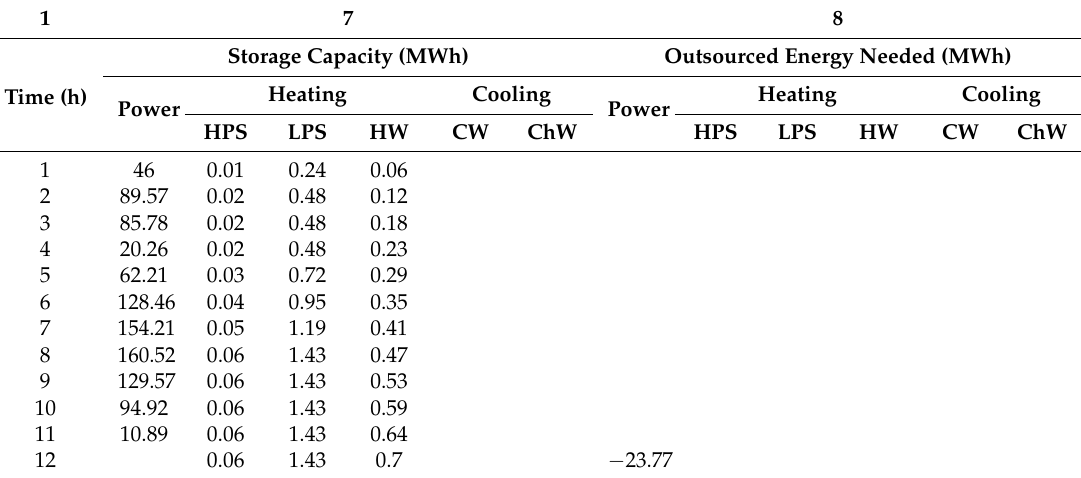
Table A17. TriGenSCT after iteration from 1 to 12